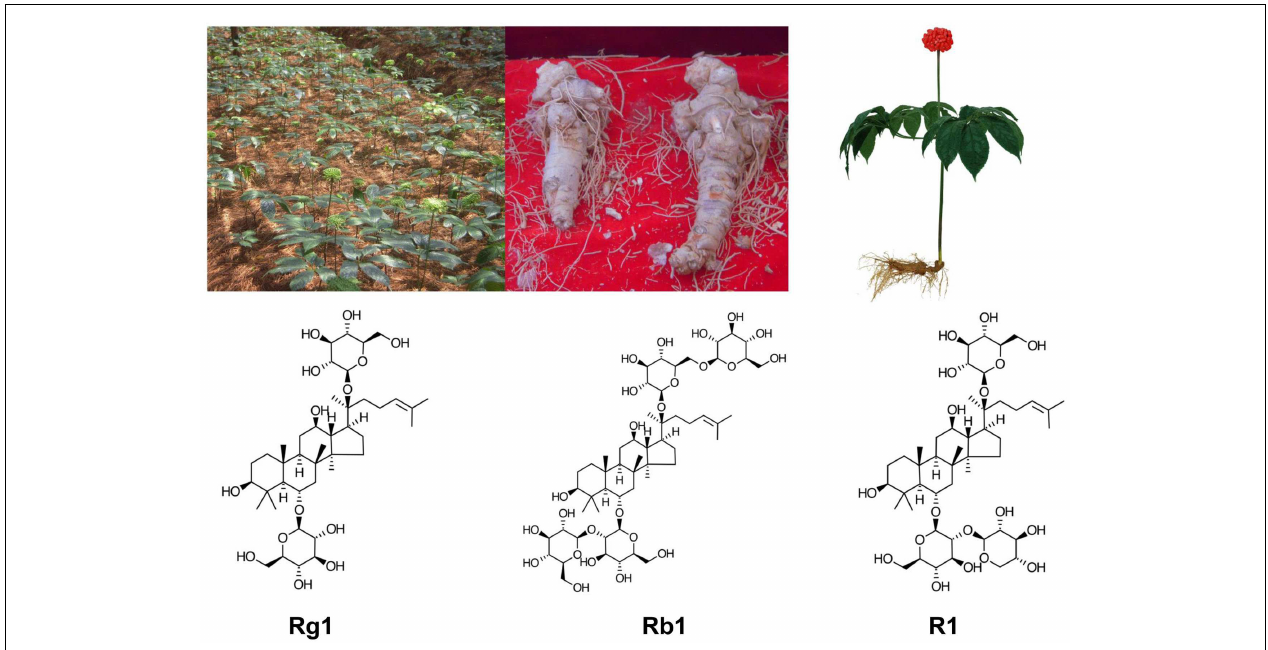
FIGURE 1 | Panax notoginseng ( P. notoginseng , Sanqi): clockwise from top left: in cultivation, the roots, artistic drawing a Sanqi plant, the main chemical ingredients of PNC: notoginsenoside R1, ginsenosides Rb1, and Rg1 .